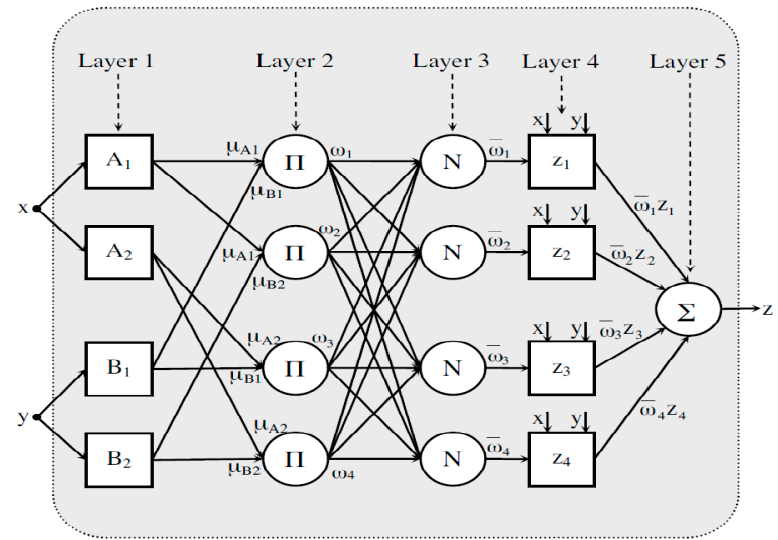
Figure 5. The architecture of ANFIS.